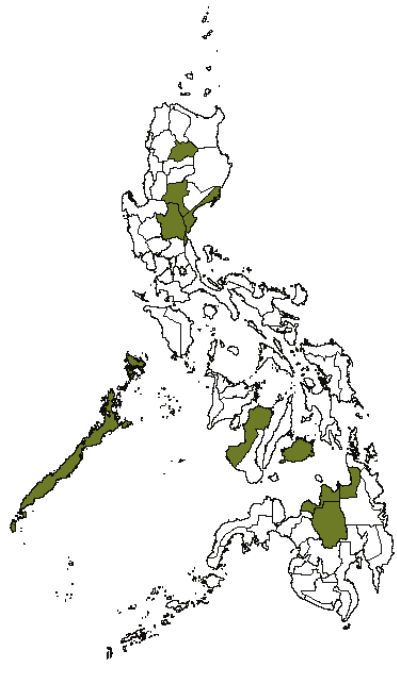
Figure 4. Philippine map showing the provinces (areas in green) where the rice germplasm were collected. The map was generated using DIVA-GIS ver.7.5.0